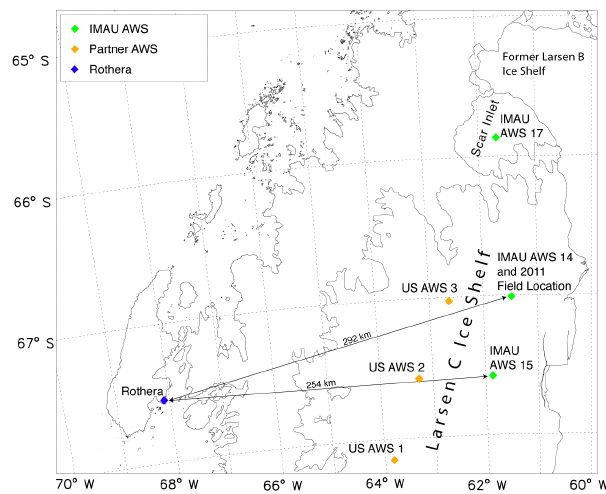
Fig. 1. Map of the Antarctic Peninsula central section. UU/IMAU AWS network locations shown in green; partner AWS network shown in orange; Rothera Research Station shown in blue.